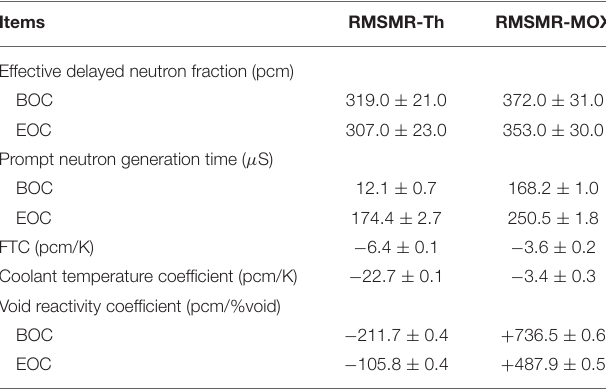
TABLE 3 | Reactor safety characteristics of